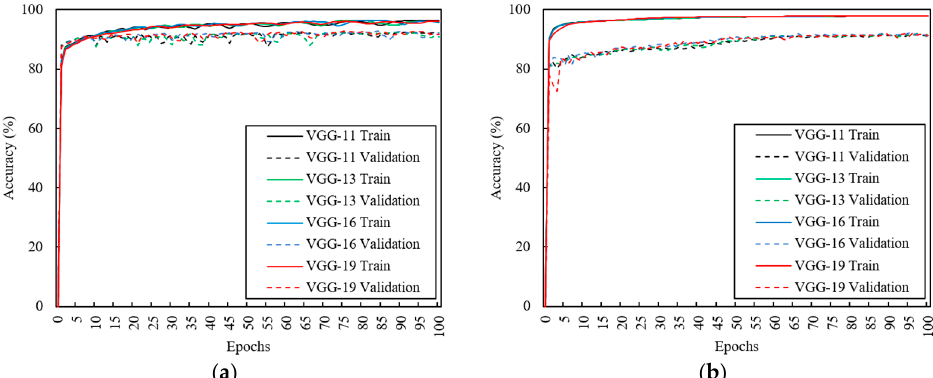
Figure 5. Learning curves of VGG-11, VGG-13, VGG-16, and VGG-19 for training and validation data according to 100 training epochs. ( a ) Raw dataset; ( b ) Augmented dataset.